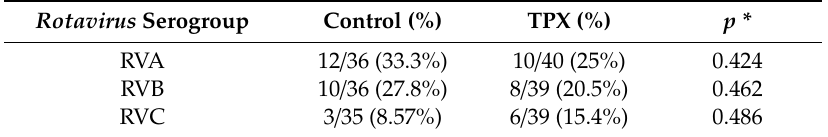
Table 3. Incidence (number and %) of RVA, RVB, and RVC positive samples in the TPX and Control